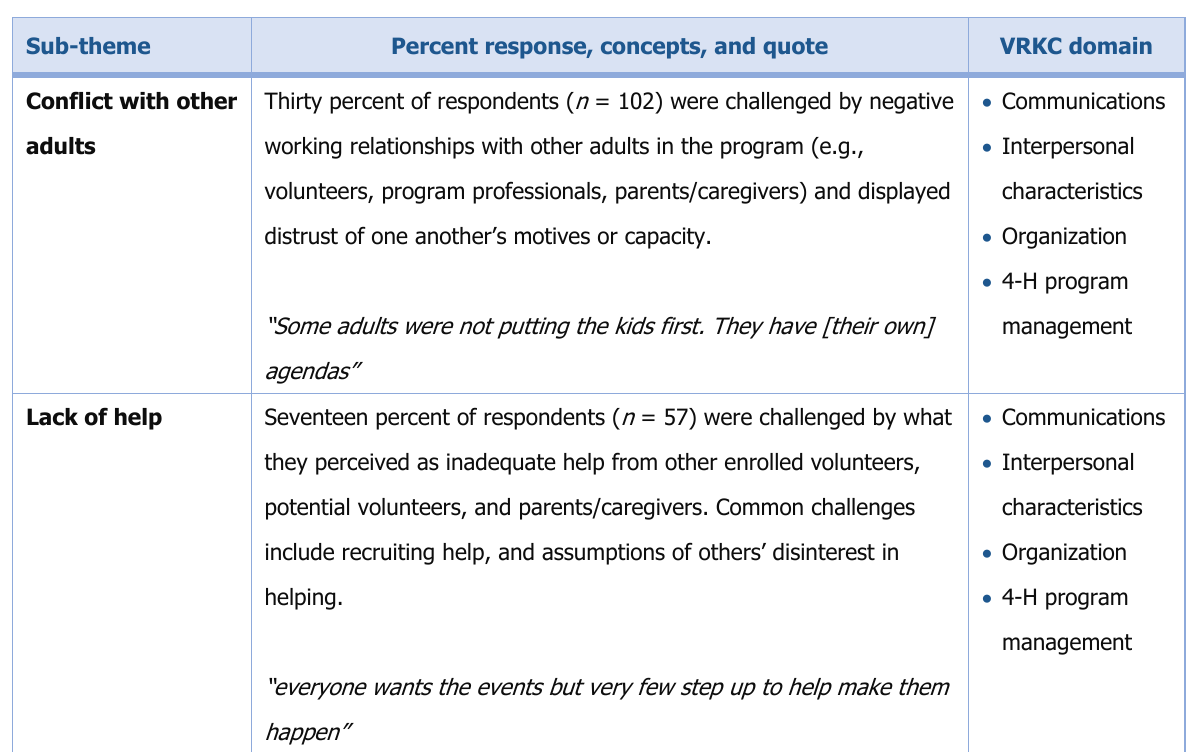
Table 6. “Challenges” Sub -Themes of the Supportive Relationships